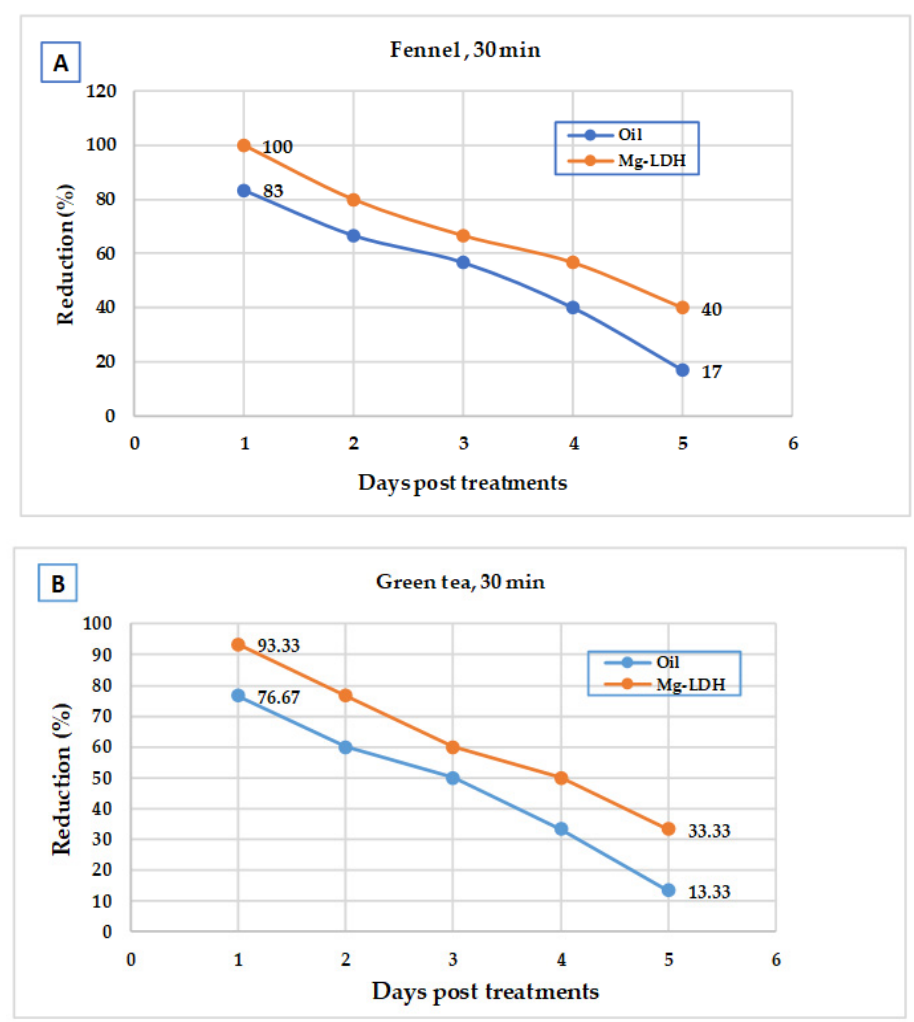
Figure 10. Persistence of Fennel oil and its Mg-LDH fennel ( A ), and green tea oil and its Mg-LDH tea ( B ) against the adult mosquito in treated homes, 30 min post exposure for 5 days.